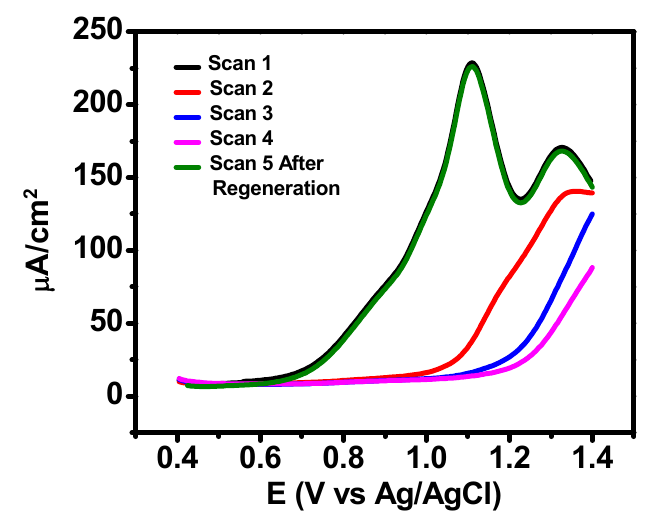
Figure 5. Differential Pulse Voltammetry ( DPV) responses of the GO on Glassy Carbon Electrode(GCE) recorded in 0.1M PBS (pH 7.2) containing 300 µ M naproxen.